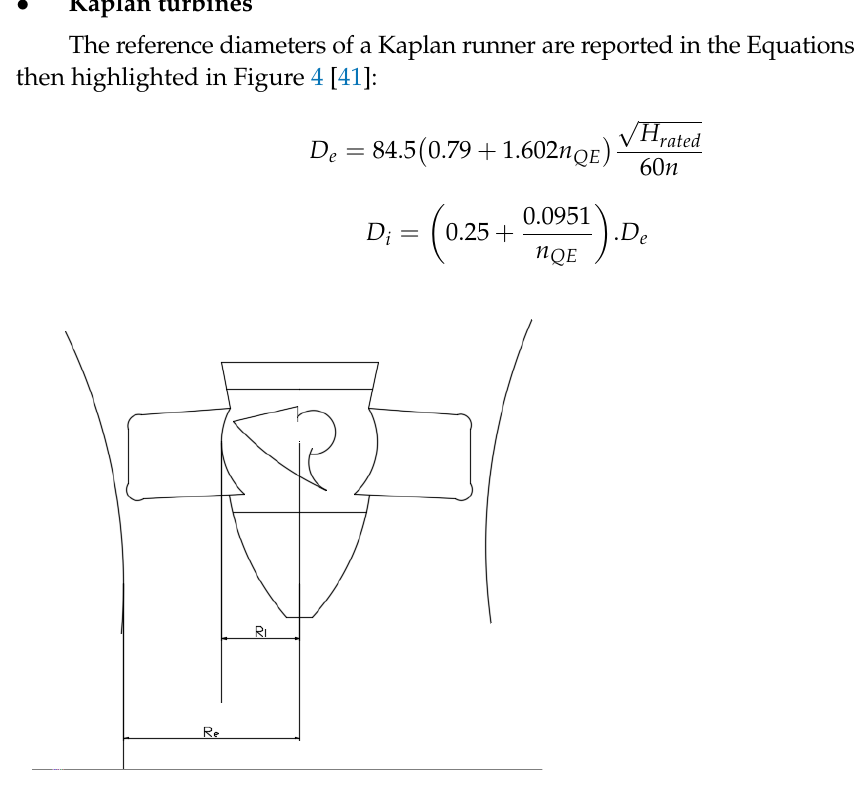
Figure 4. Cross section of a Kaplan turbine.